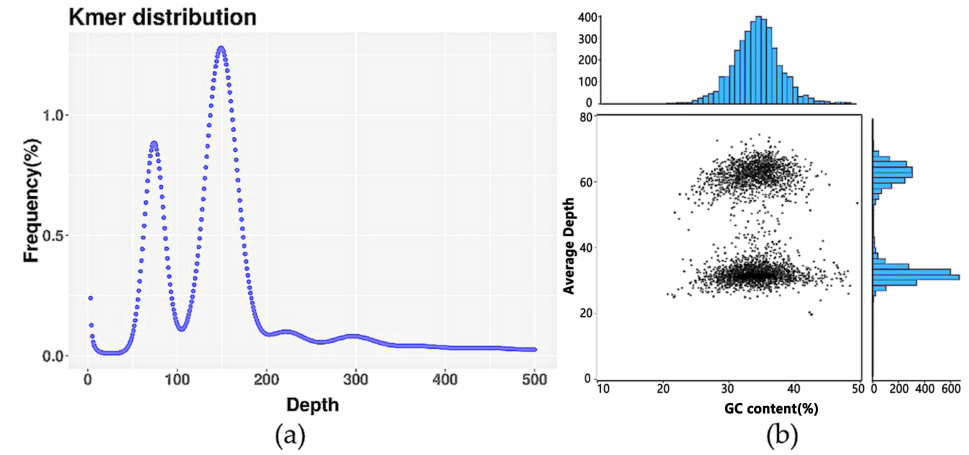
Figure 2. Diagram showing k-mer distribution, GC content, and average sequencing depth: ( a ) 21 k-mers for estimating the genome size of D. hupeana . ( b ) For scatter plots, the X-axis represents GC content and the Y-axis represents the average depth. For the histograms, the X-axis represents the GC content and the Y-axis represents the frequency distribution of sequencing